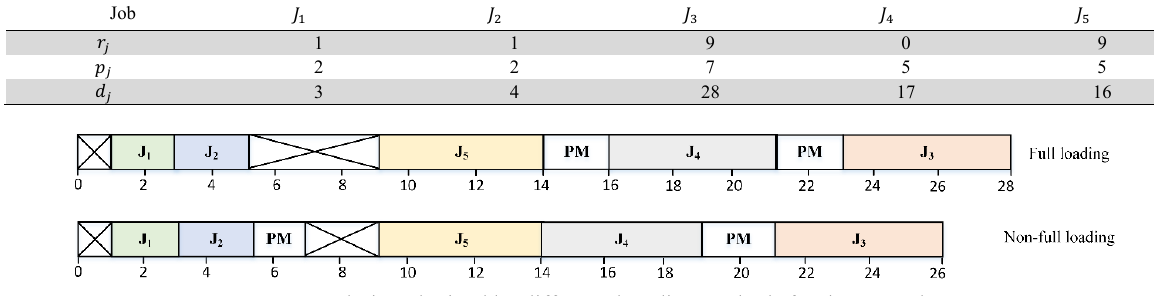
Fig. 2. Solution obtained by different decoding methods for the